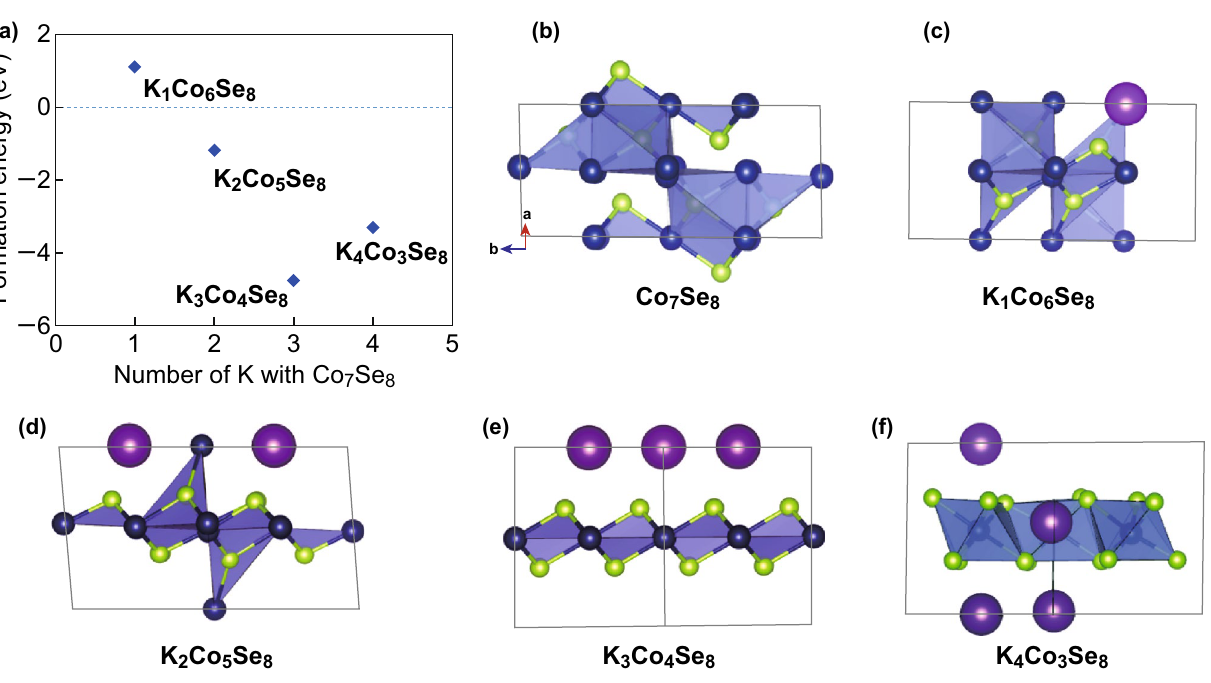
Fig. 5 Density functional theory (DFT) calculations. a Relationship between the formation energy and the number of K. b – f Schematic molecu‑ lar structures of the formed